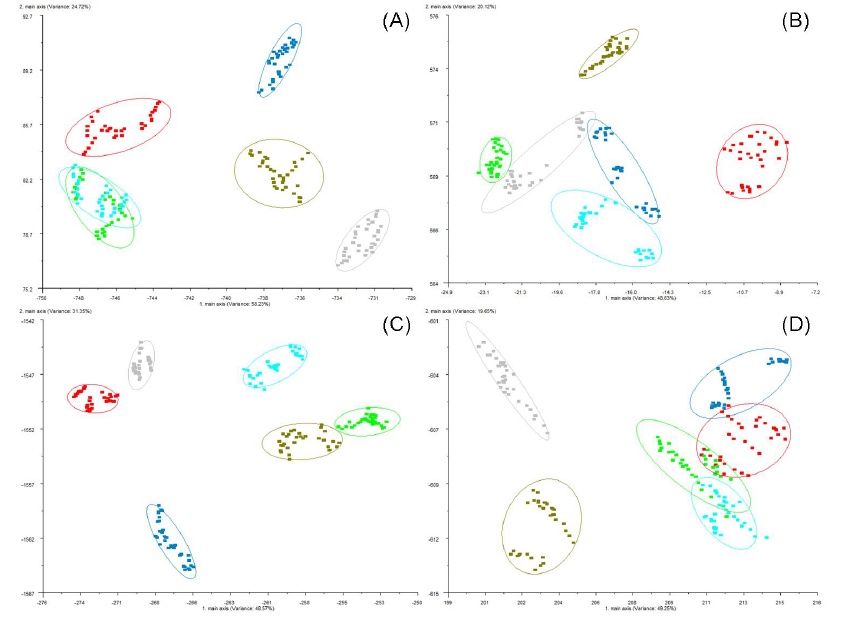
Armillaria mellea (green); wood decayed by Ganoderma lucidum (cyan); wood decayed by Armillaria ostoyae (dark blue); wood decayed by Heterobasidion annosum (olive);